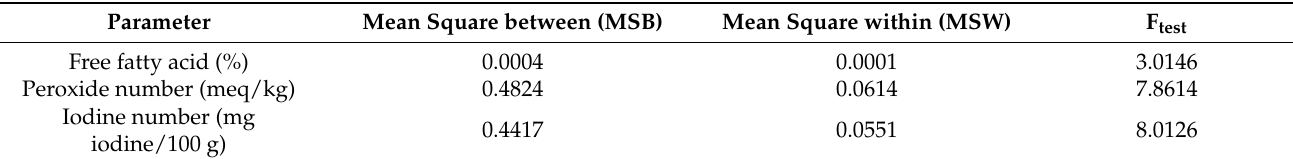
Table 4. Homogeneity test of VCO